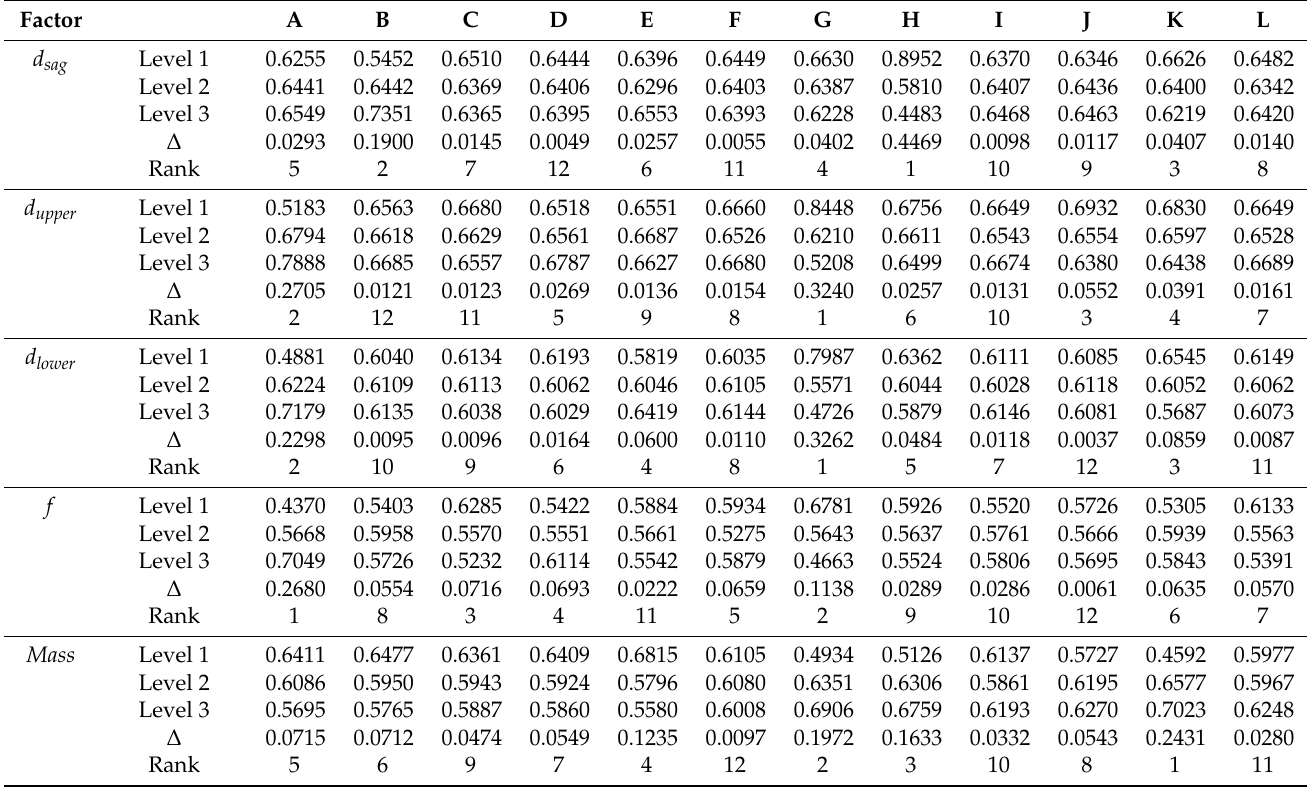
Table 7. Mean grey relational degree at each level for each factor in the automotive door TWB